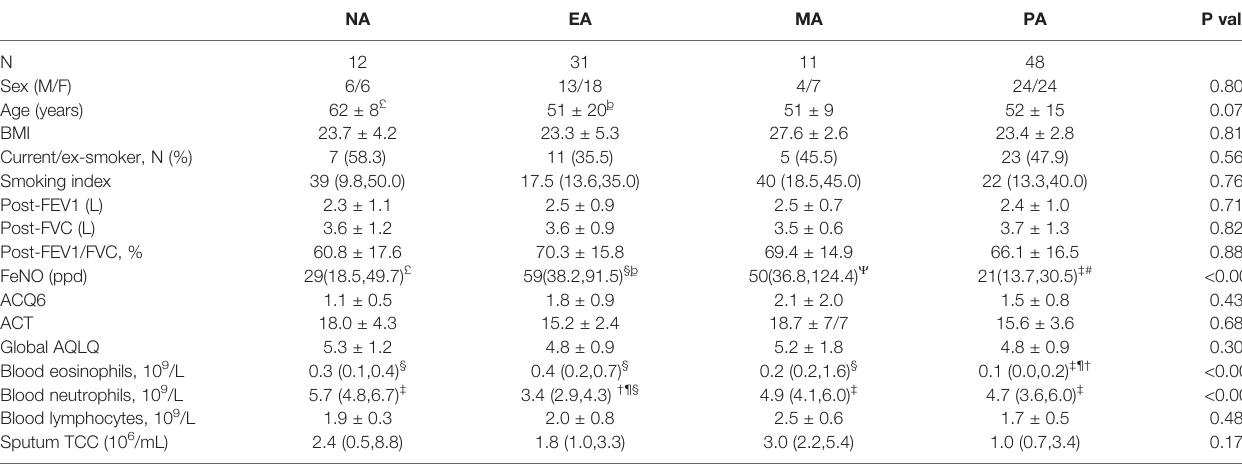
TABLE 3 | Demographic and clinical characteristics according to the in fl ammatory phenotype. NA EA MA PA P value